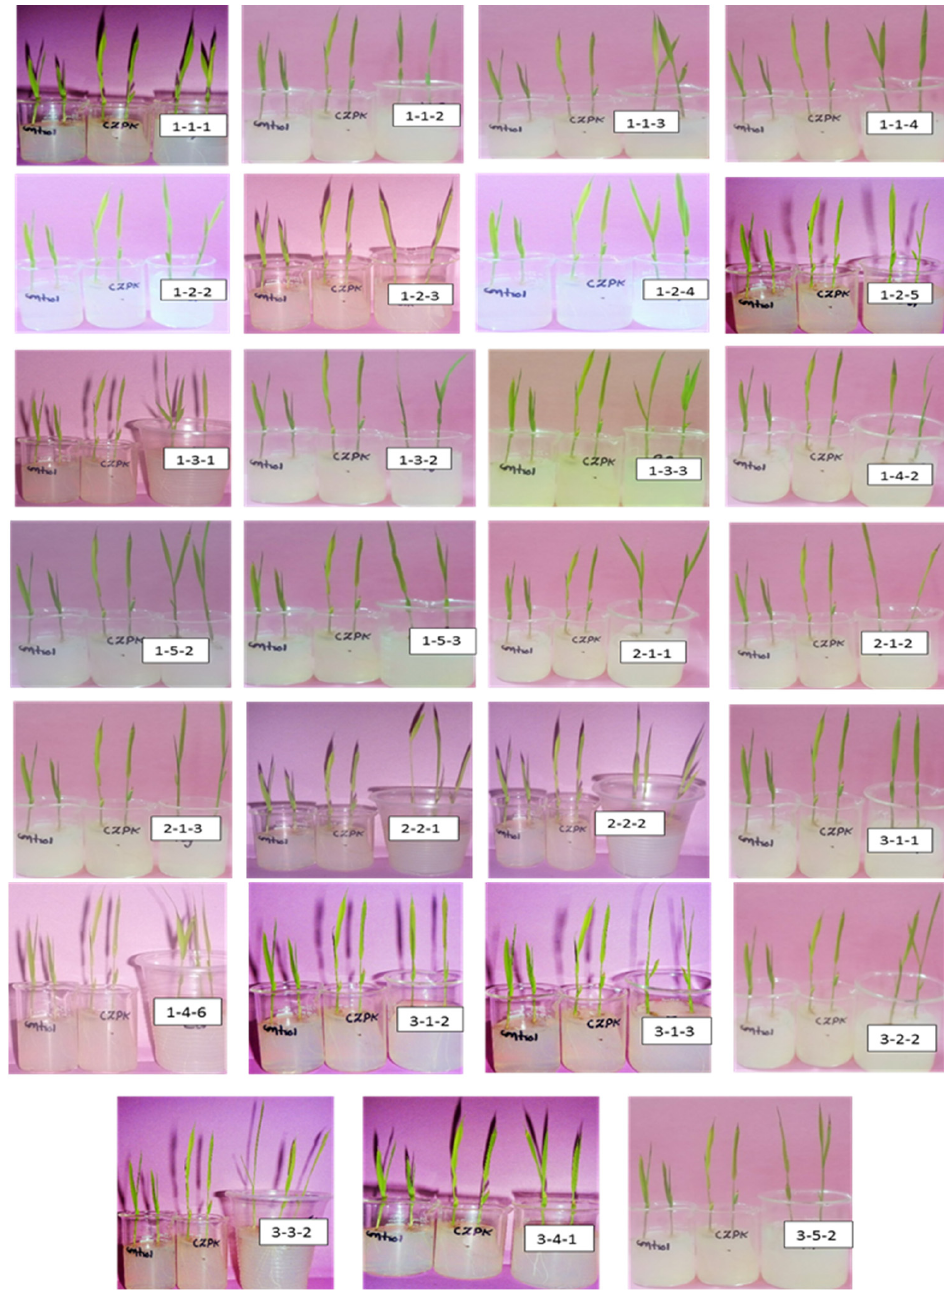
Figure 1. Screening bioassay of fungal culture filtrates on Waito-C rice seedlings. Twenty-seven fungal isolates were screened; all had a growth-promotion effect on seedlings (after 7 days of incubation), after being treated with 10 μ L of concentrated culture filtrates of respective fungi.